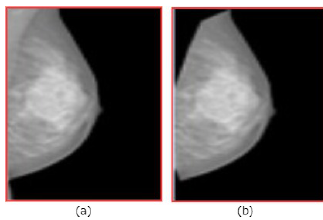
Figure 3. ( a ) Original images. ( b ) After removing pectoral muscle.